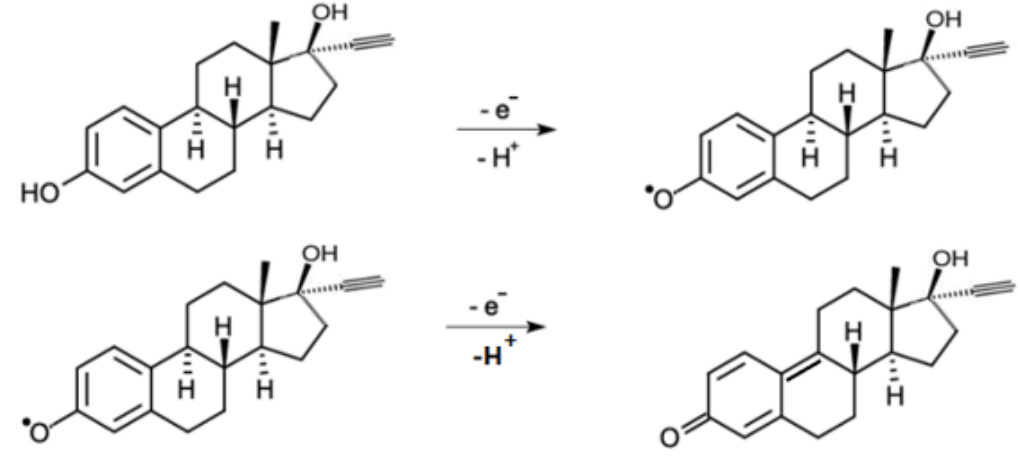
Figure 13. Proposed mechanism of reaction for the oxidation of ethinyl estradiol. (figure adapted from the work of Santos, K.D) [43].